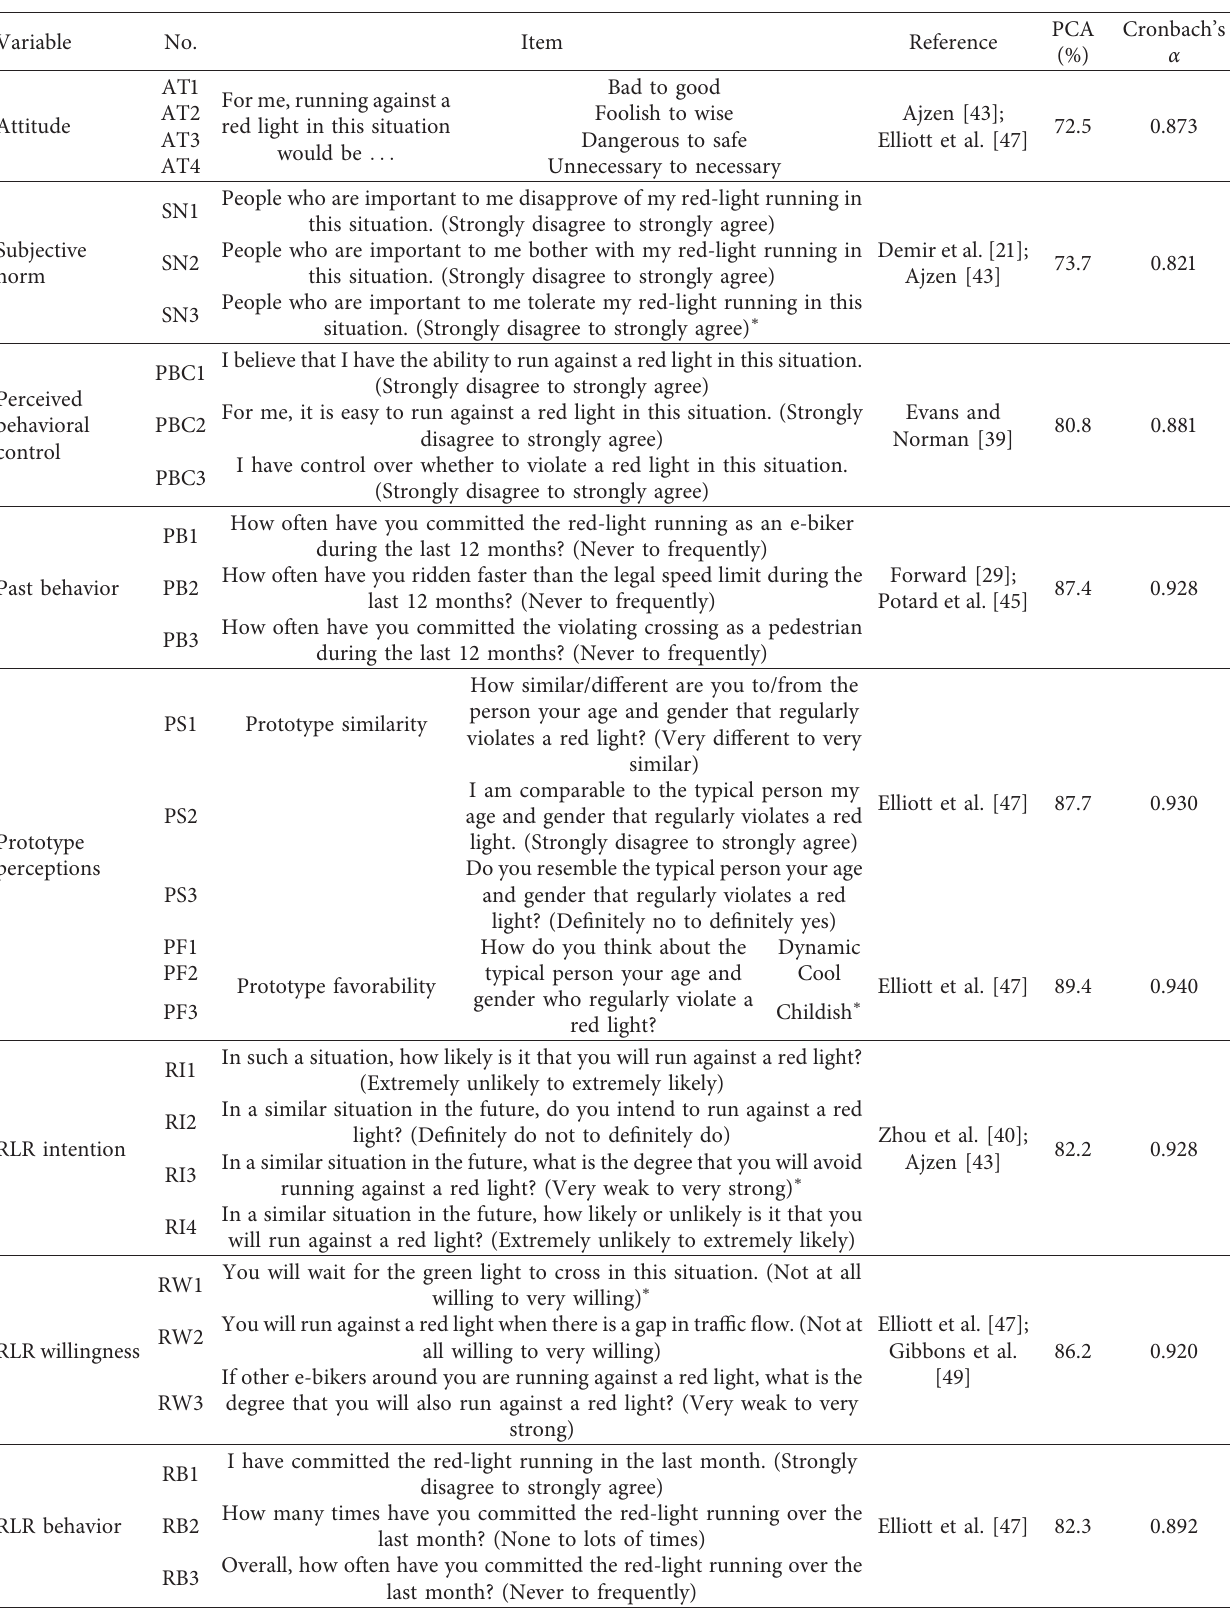
Table 1: Summary of items and internal